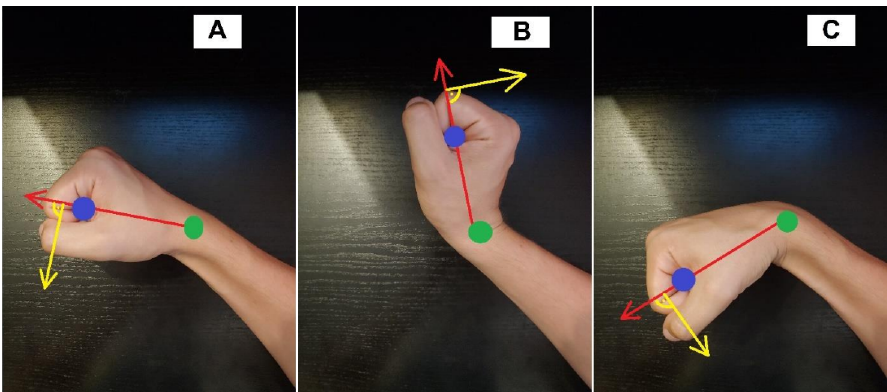
Figure 5. Wrist positions with vectors plotted against which wrist flexion/extension angle was measured. ( A ) vector created while the hand is in the entry position, ( B ) vector created for the wrist extension, ( C ) vector created for the wrist flexion.